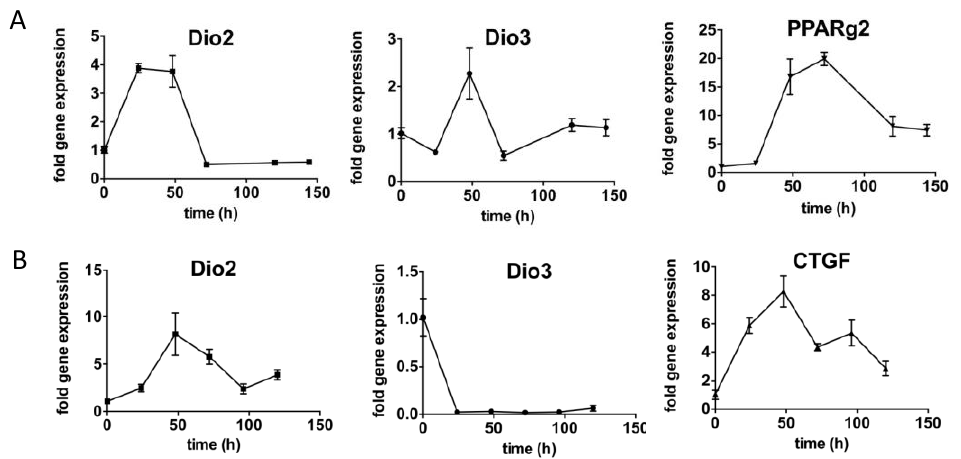
Figure 5. Primary culture of FAP cells differentiated to adipocytes. ( A ) Presence of PPARg2, con- firming adipocytes, showing the expression of Dio2 and higher expression of Dio3. ( B ) Presence of CTGF, confirming the presence of collagen and indicating differentiation into myofibroblasts, show a substantially higher expression of Dio2 with no expression of Dio3.